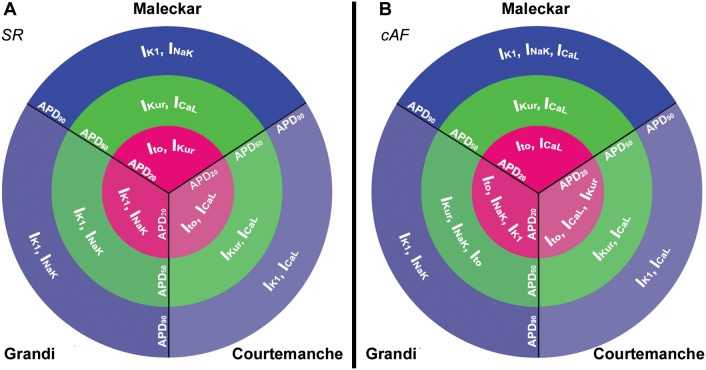
Ionic modulators of APD90, APD50 and APD20 in SR and cAF.Ionic conductances identified as having a stronger influence on human atrial cells APD90 (blue), APD50 (green) and APD20 (magenta), in SR (A) and cAF (B) with the Maleckar, Courtemanche and Grandi model populations.